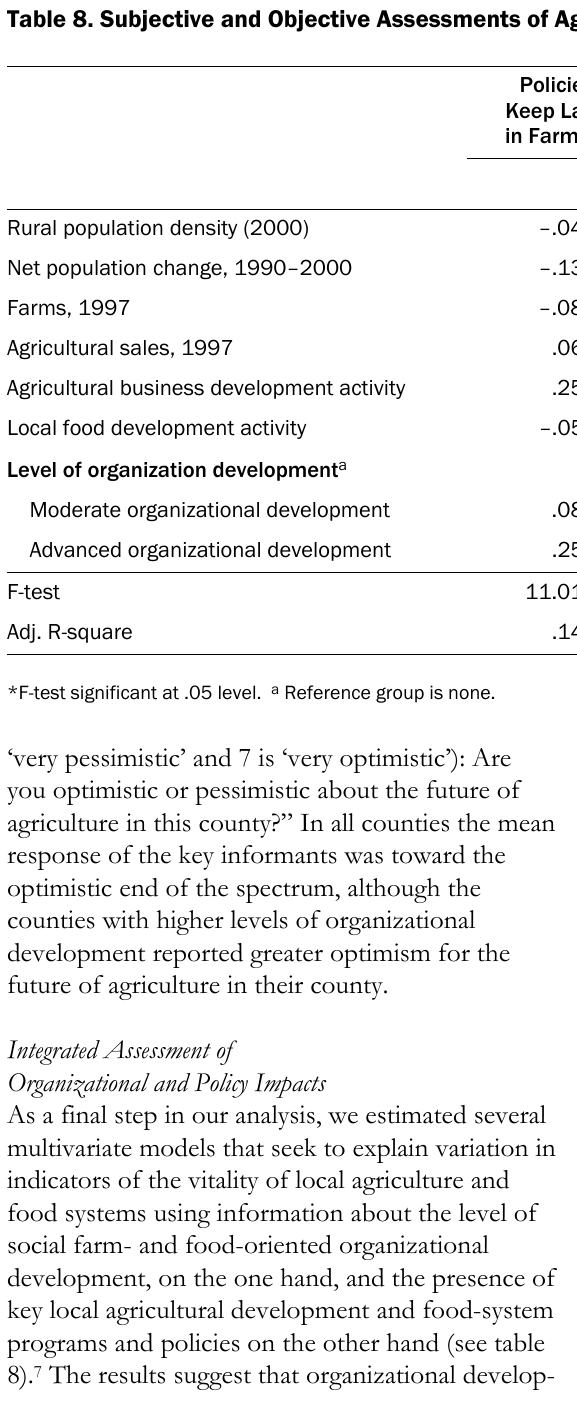
Table 8. Subjective and Objective Assessments of Agricultural